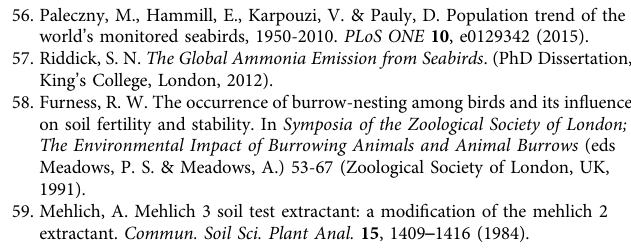
Fig. 1. We dedicate this work to the memory of Antonio Sierra and Susiño, two great and irreplaceable